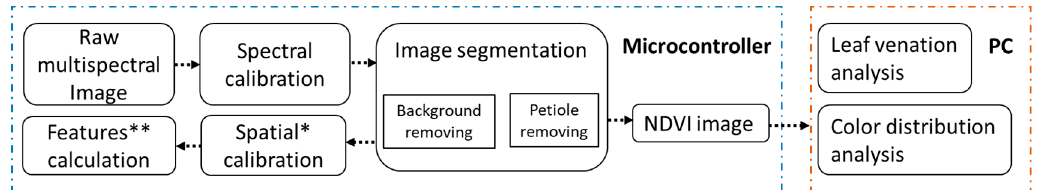
Figure 2. Image processing on microcontroller and computer (PC). Leaf venation analysis and color distribution analysis on PC are elaborated in Section 3. * The image is calibrated with the calibration parameters hardcoded in the microcontroller. ** Features include color features and morphological features.